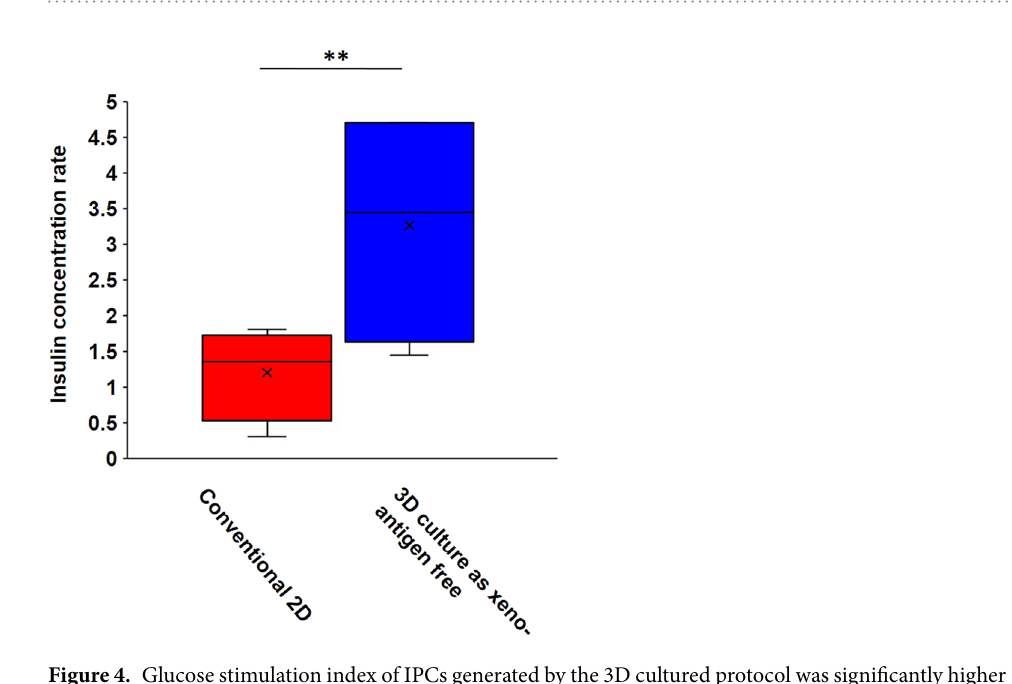
Figure 4. Glucose stimulation index of IPCs generated by the 3D cultured protocol was significantly higher than IPCs generated by conventional 2D culture. The lines in the boxes show the median values, and the error bar shows the standard deviation. Unpaired t-test, ** P <